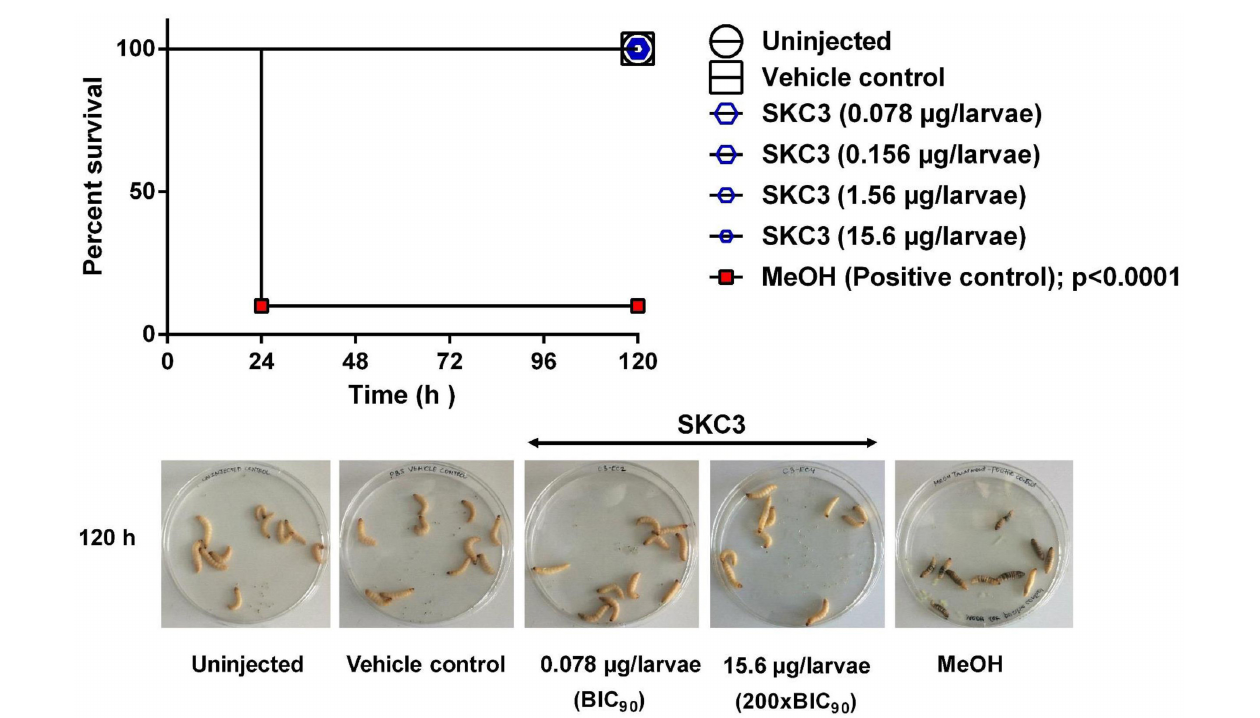
FIGURE 5 | In vivo toxicity evaluation of SKC3 on Galleria mellonella larvae. No death was observed in the larval groups treated with vehicle control (1 × PBS; endotoxin-free) and SKC3 (BIC 90 − 200 × BIC 90 ). MeOH treatment lead to 90% death of the